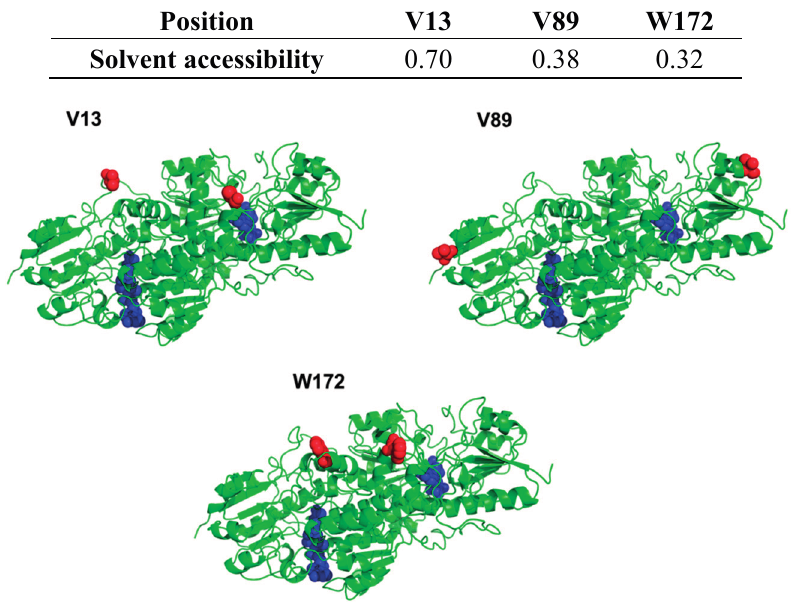
Table 1. Solvent accessibility of three incorporation sites in the TsFDH.